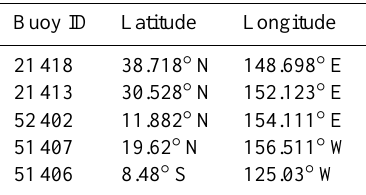
Table 2. ID and location of the DART buoys used to quantify the wave height in deep